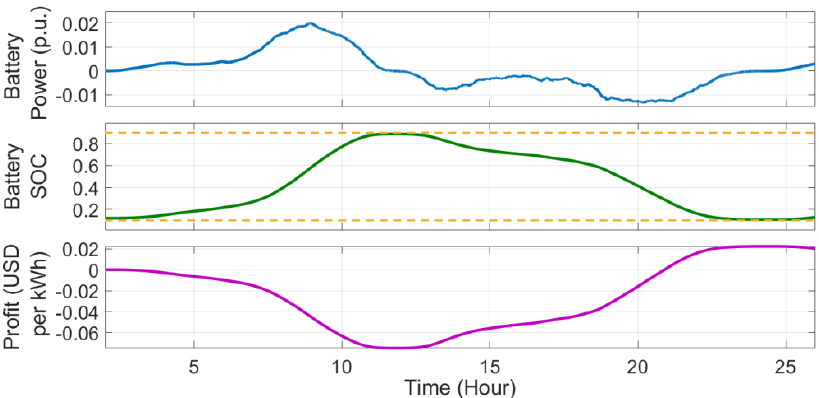
Figure 22. Battery system response to the electricity price signal.